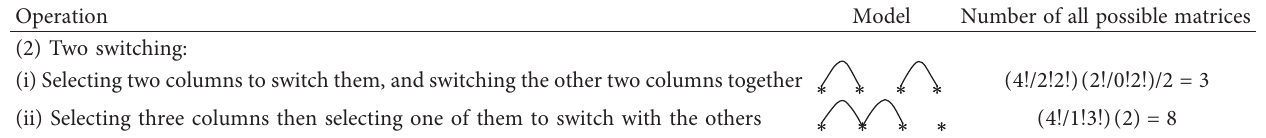
Table 3: Two switching operations.